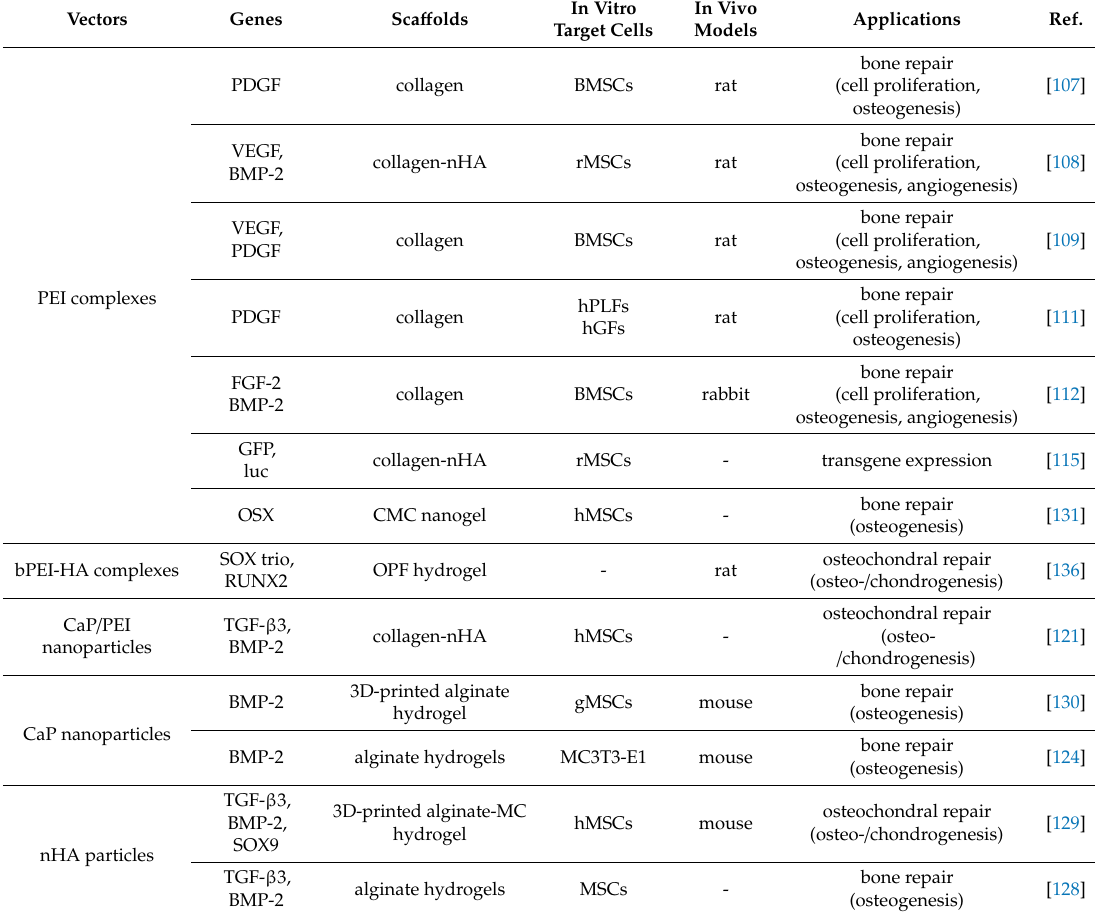
Table 3. Sca ff old-mediated nonviral gene delivery.